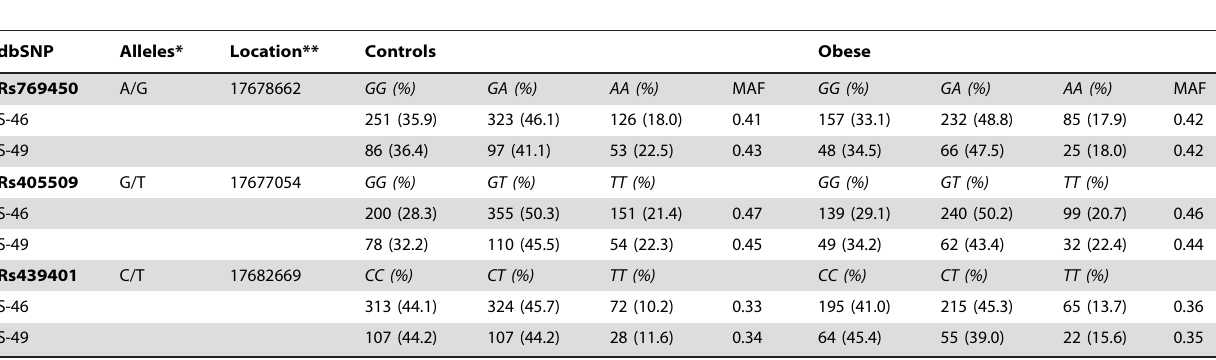
Table 1. Genotype distribution of APOE rs769450, rs405509 and rs439401 for controls and obese participants in absolute numbers and percentages at survey S-46 (n= 1,186) and S-49 (n=385).